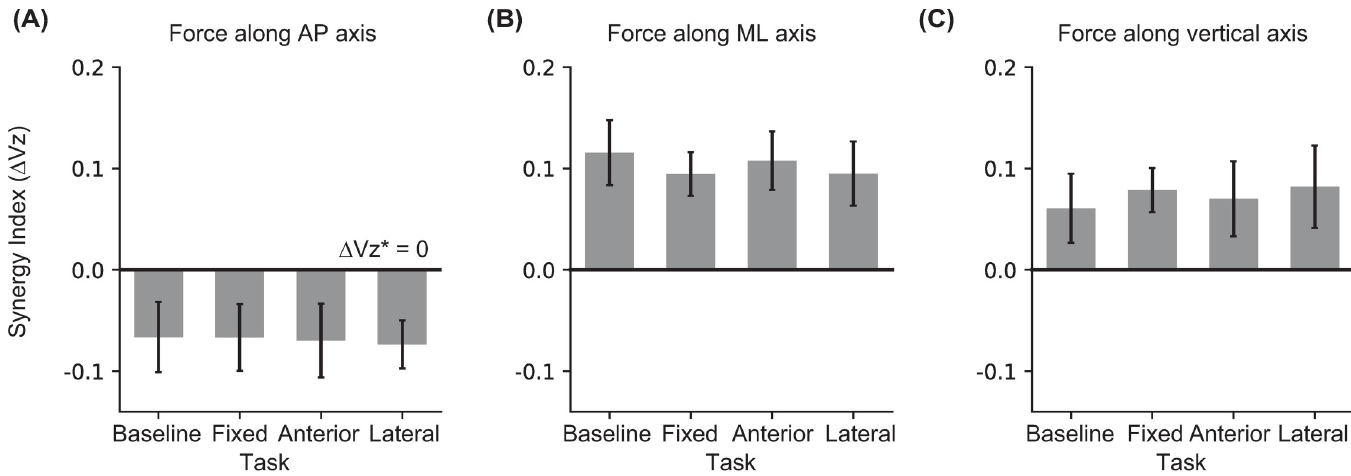
Fig 5. The mean and SE for synergy index ( Δ Vz) for stabilizing resultant force along the (A) AP, (B) ML and (C) vertical axis during the double support phase for the four tasks. The horizontal lines in each plot show the discriminating values for each synergy index.